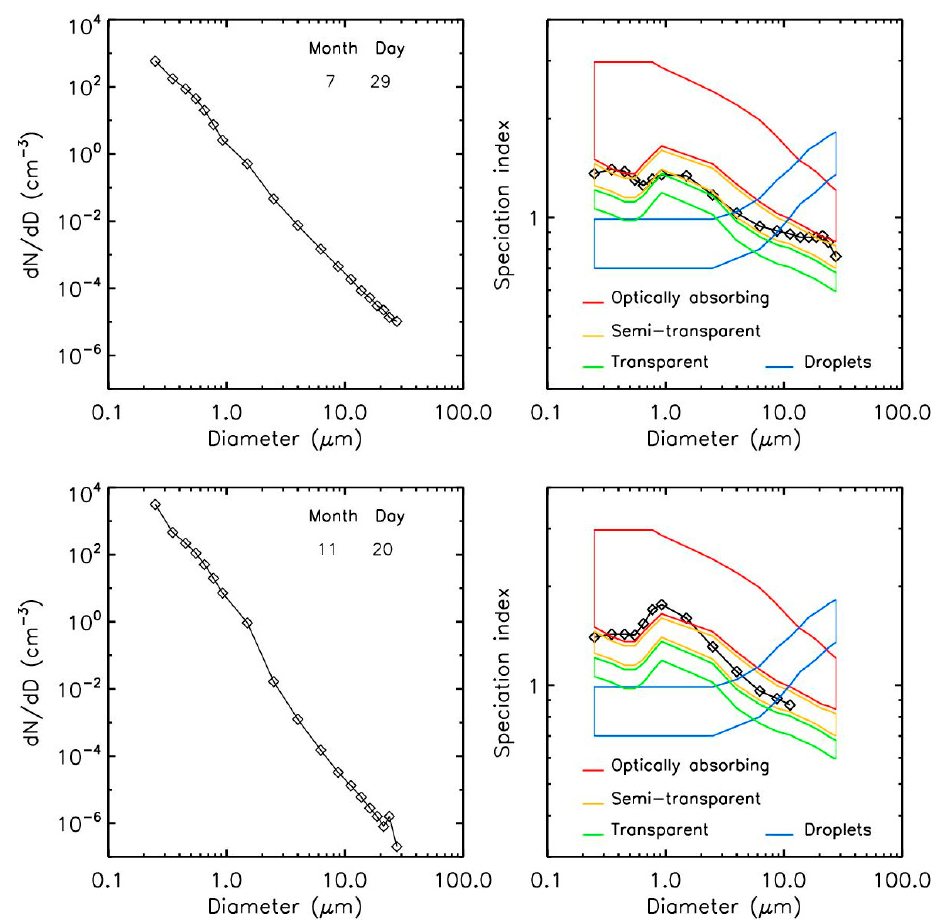
Figure 2. Size distribution ( left ) and typology ( right ) from the LOAC measurements; ( top ) during summer, ( bottom ) during late in the fall.